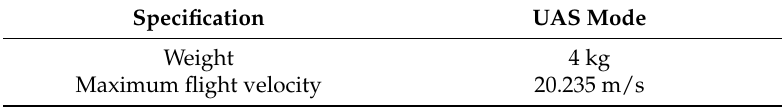
Table 1. Attributes of UAS model based on Class 1 Micro unmanned aerial vehicle (UAV) classification.